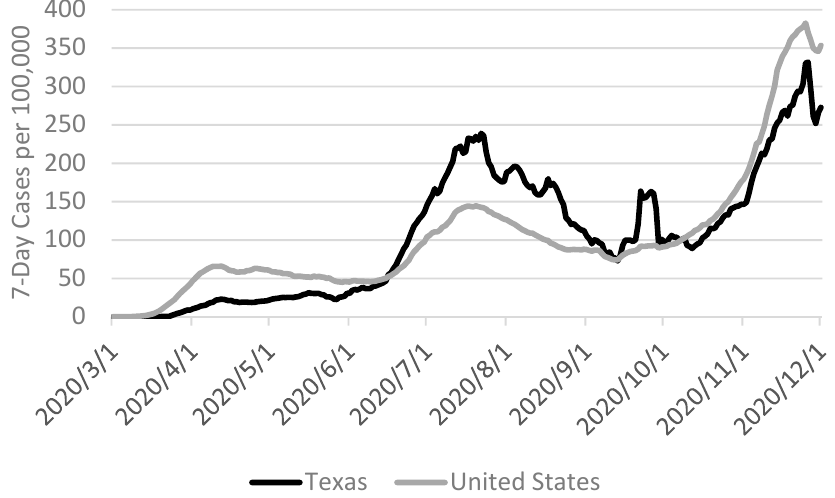
Figure 2. Daily trends in seven-day cumulative incidence rate of COVID-19 cases in Texas and the United States per 100,000 population [43].